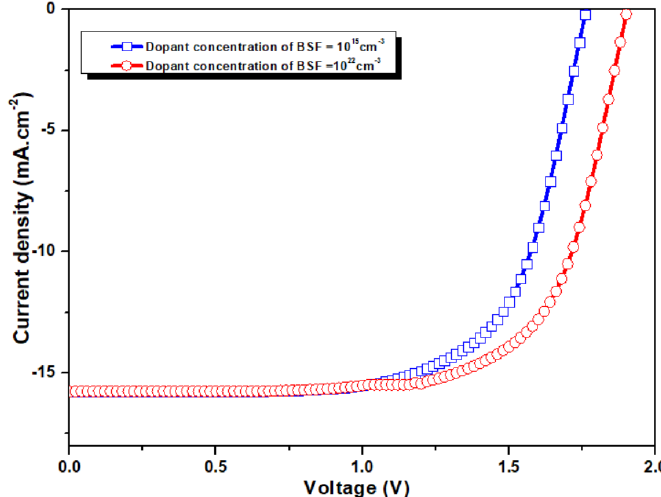
Figure 14. The I – V characteristic of the optimized tandem solar cell. As observed from the results, for the optimal dopant concentration of the BSF layer, N D = 10 22 cm –3 , the open-circuit voltage of the tandem device increases. The J – V characteristics of the top sub-cell, the bottom sub cell, and the tandem cell are presented in Figure 15, and the photovoltaic parameters are reported in Table 3.